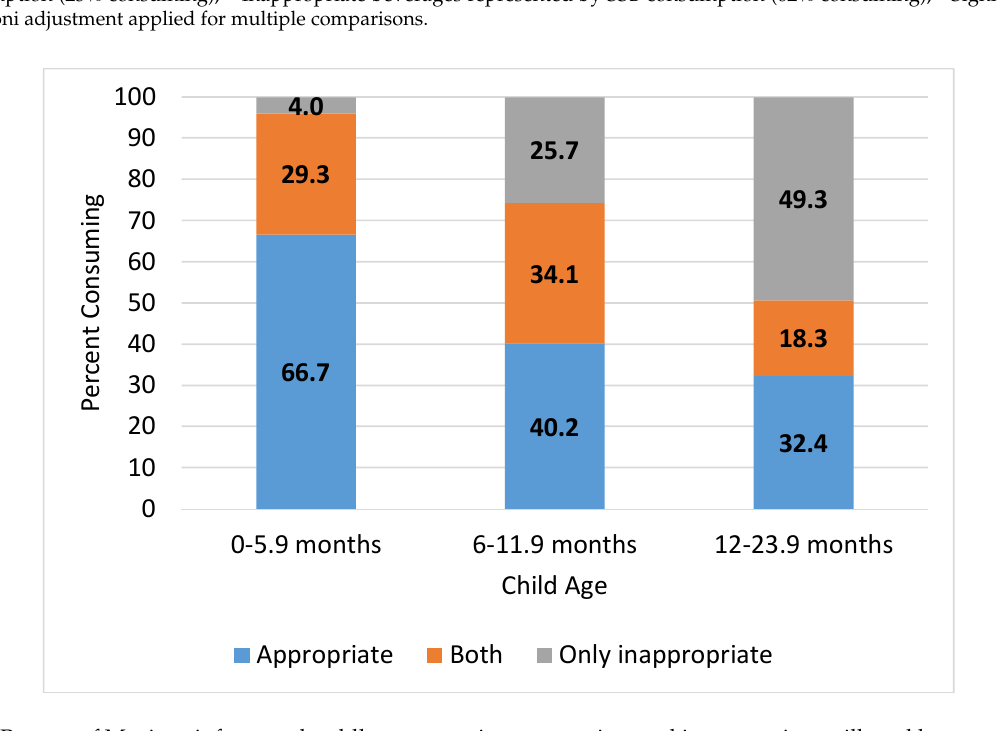
Figure 1. Percent of Mexican infants and toddlers consuming appropriate and inappropriate milk and beverages by age.